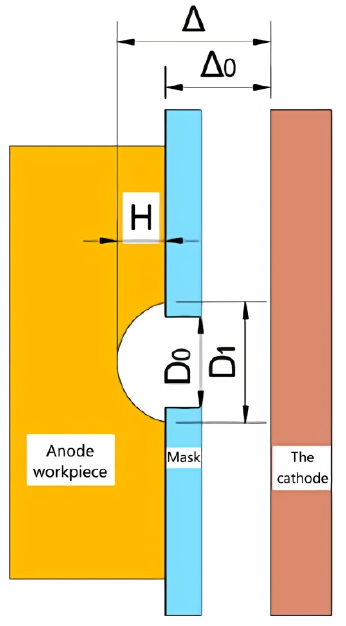
Figure 2. Schematic diagram of the position of the mask electrochemical machining.